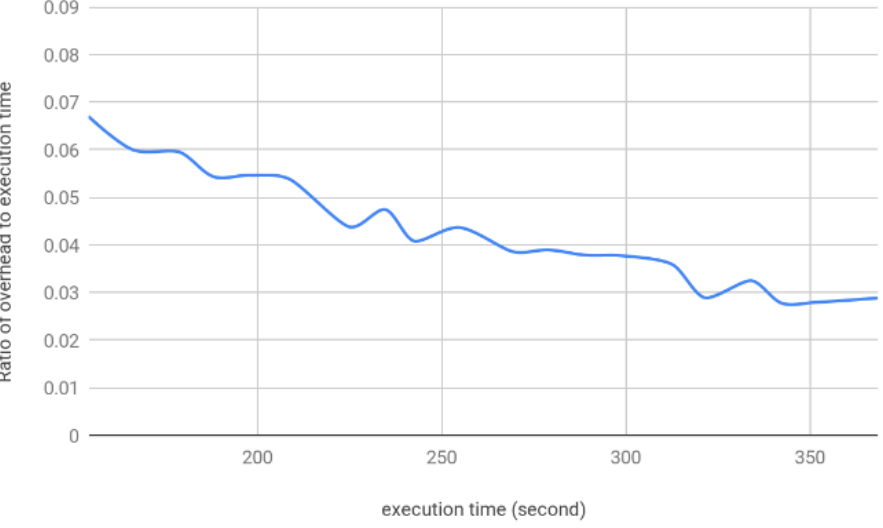
Figure 9. Ratio of overhead to whole process time.